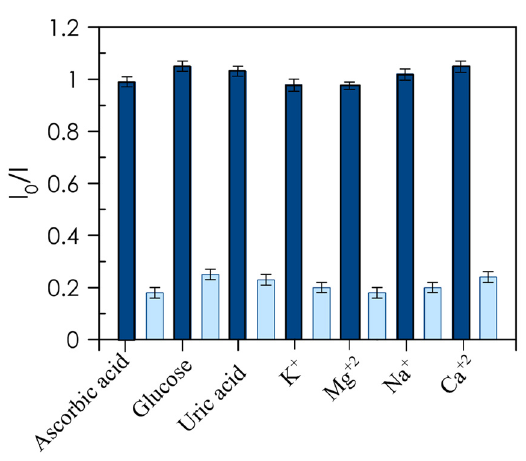
Figure 8. Selectivity of RTP assay. Response of interferents (10 µ M for ascorbic acid, glucose, and uric